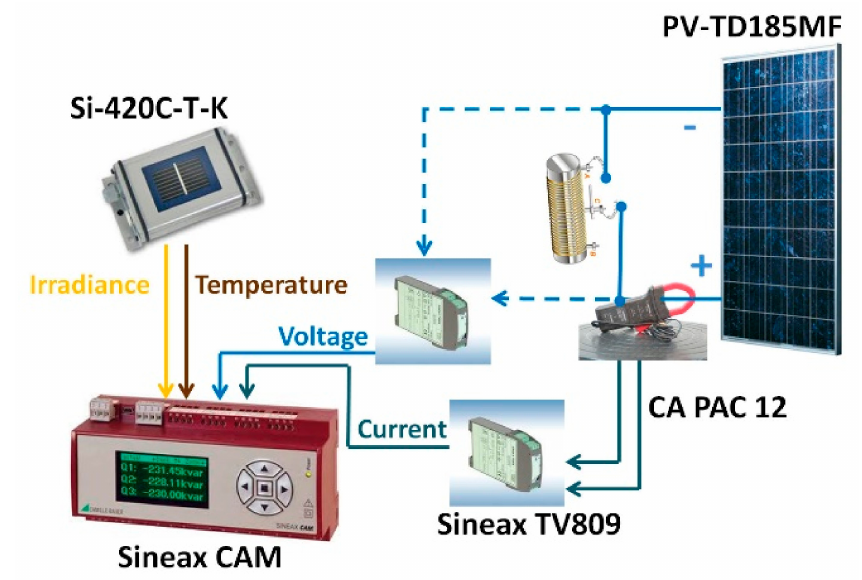
Figure 4. Data Acquisition System reproduced by permission from [19], Hindawi,